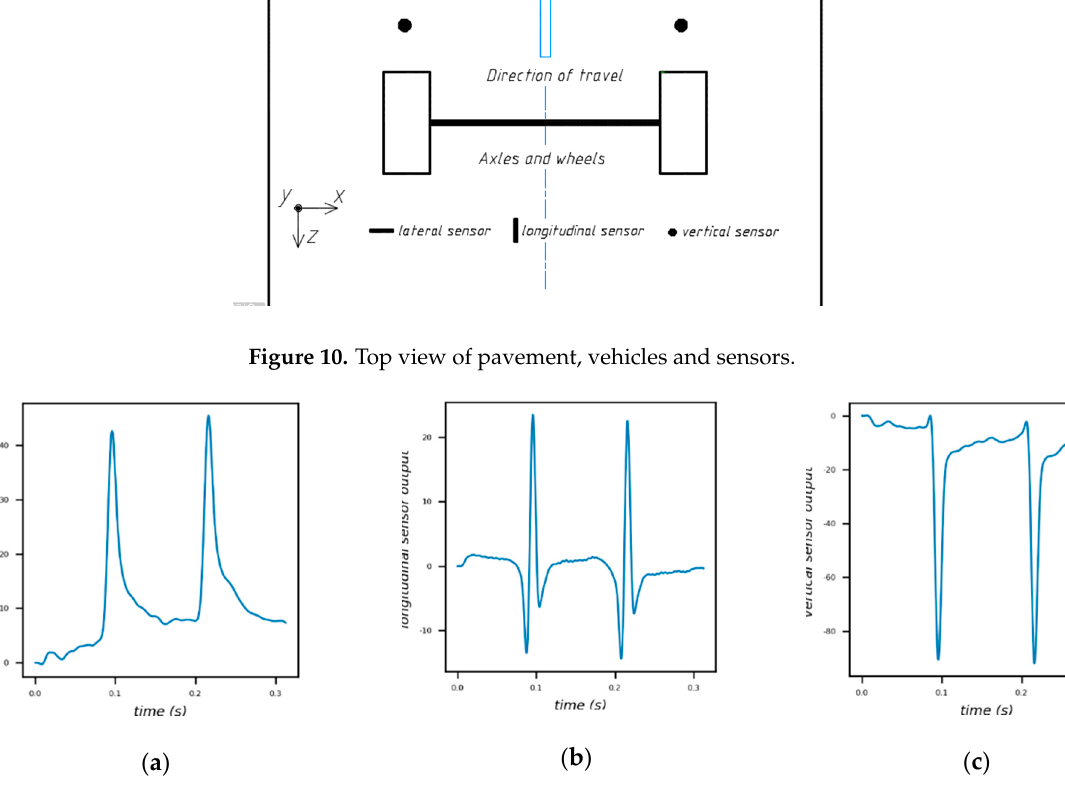
Figure 11. ( a ) Lateral sensor; ( b ) Longitudinal sensor; ( c ) Vertical sensor.